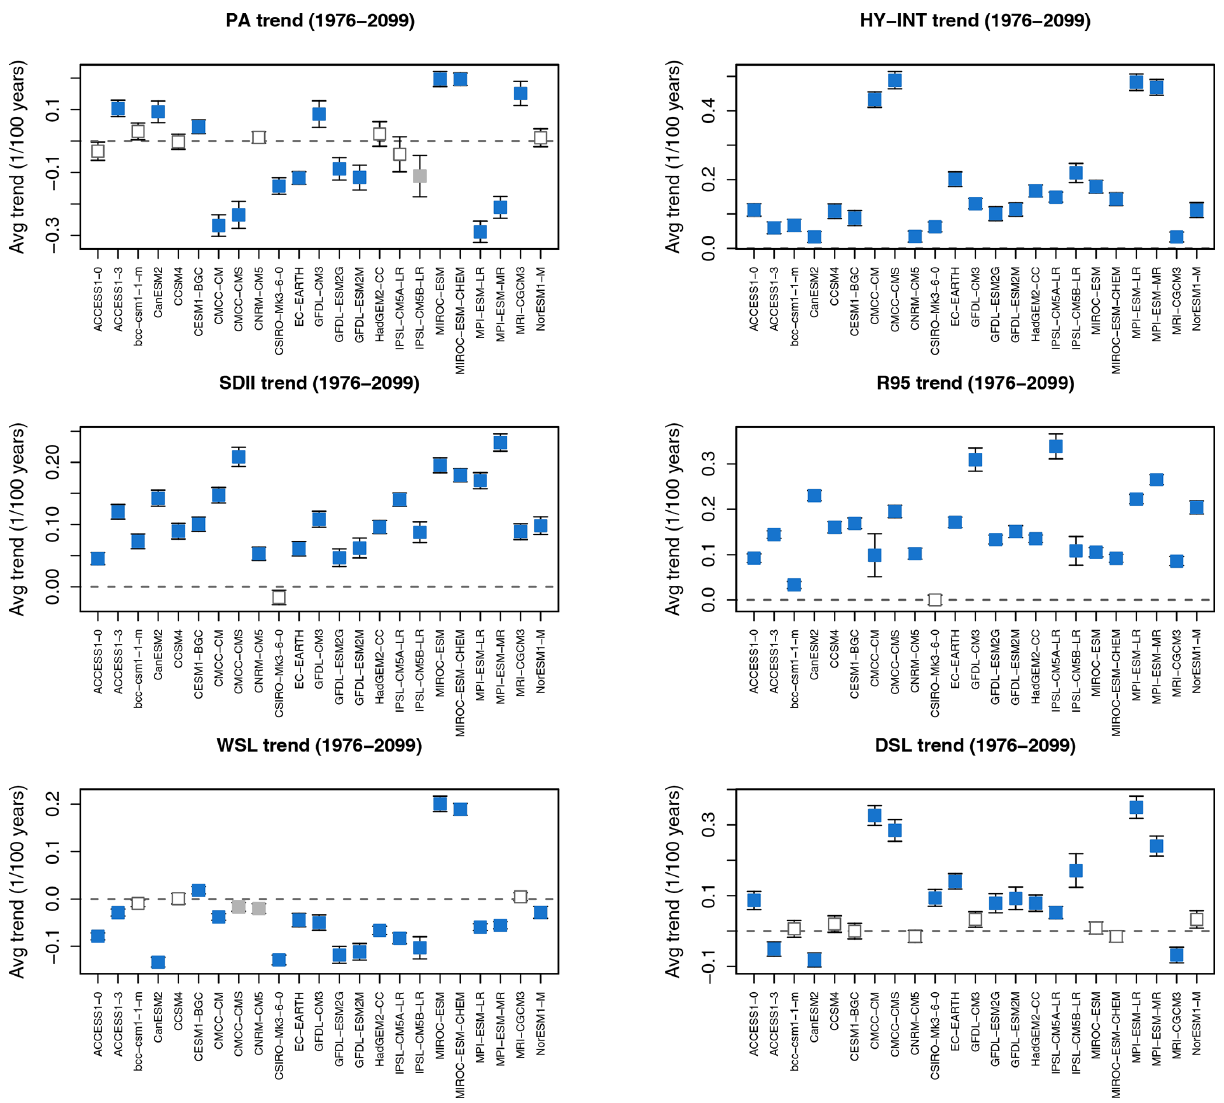
Figure 2. Trend in selected indices for an ensemble of CMIP5 models (historical + RCP8.5 projection) over the time period 1976–2099. The trends are calculated over the latitude band 60 ◦ S–60 ◦ N. Data were normalized to the historical 1976–2005 period. Indices include the precipitation area (PA), hydroclimatic intensity (HY-INT), precipitation intensity (SDII), heavy precipitation (R95), and wet and dry spell length (WSL and DSL) following Giorgi et al. (2014). Error bars show the geographical variability (standard deviation) within the region and colours the statistical significance of the trend (90% grey, 95% blue). This is an example of a large number of different plots which can be produced with recipe_hyint.yml , similar to Giorgi et al. (2014). For details see Sect. 3.1.1.